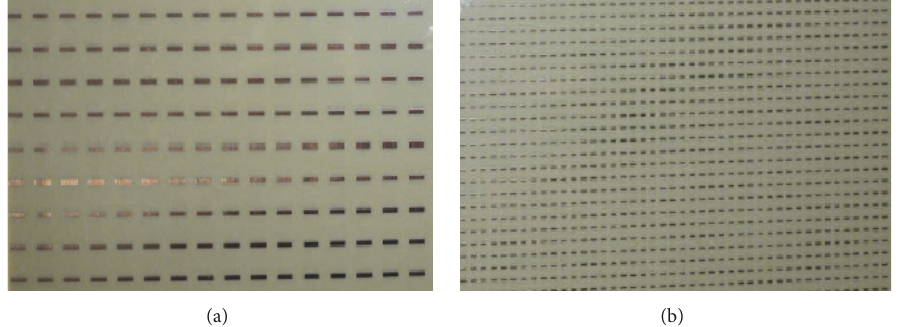
Figure 11: The X-band (a) and Ka-band (b) structures consisting of differently sized copper straight wires (strips) printed on top of the FR4 substrate.